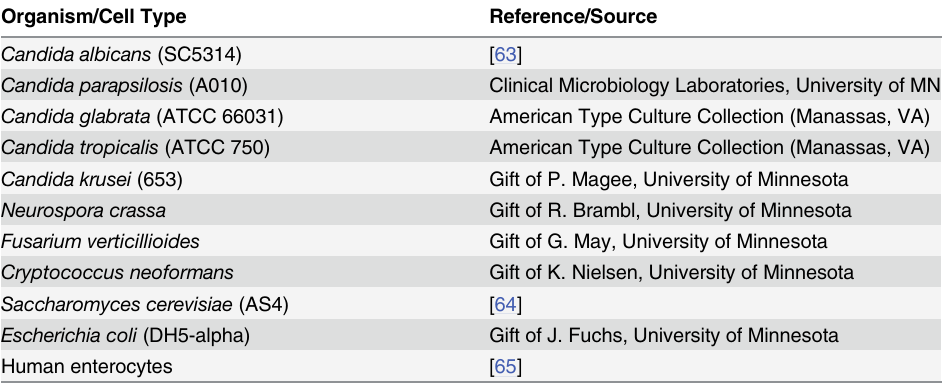
Table 2. Genomic DNA used in this